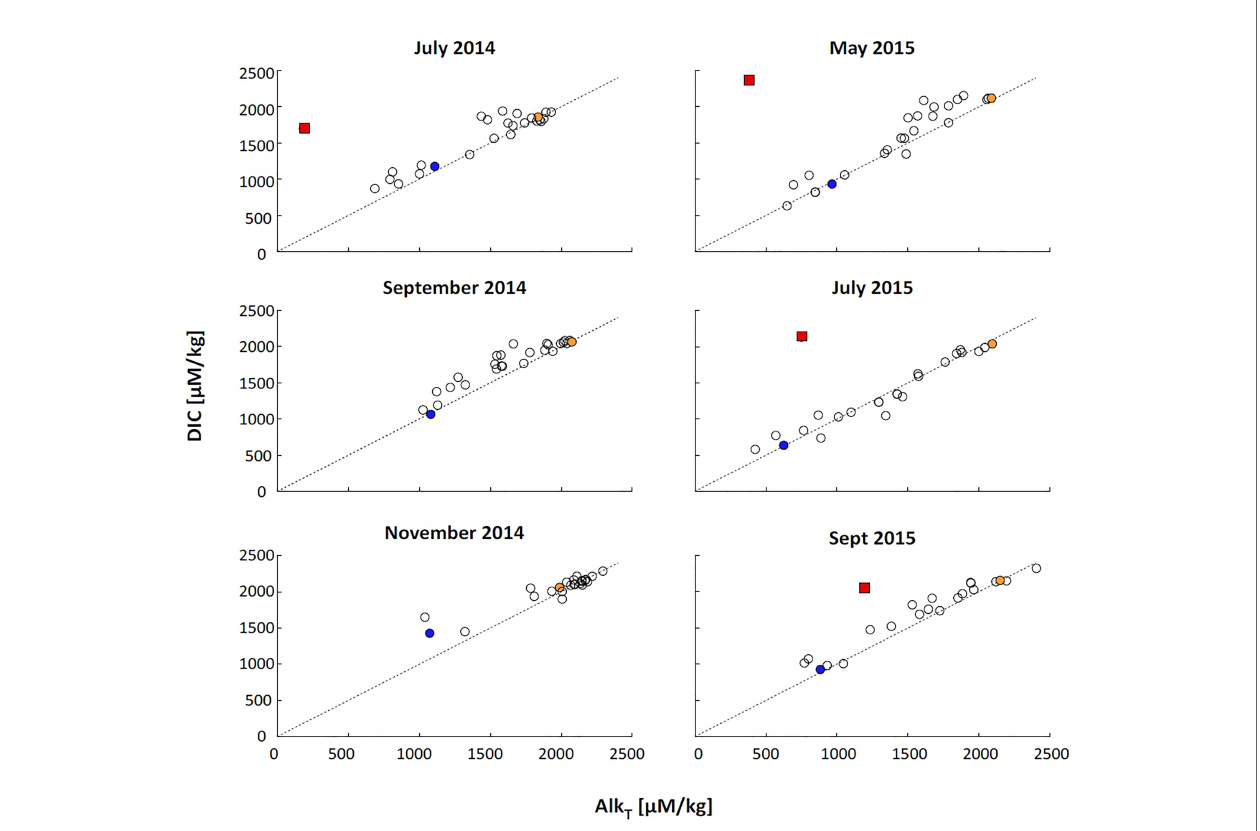
FIGURE 5 | DIC vs. T Alk T . Dotted line shows a 1:1 ratio. Lowest (blue) and highest (orange) salinity sample are indicated. With the exception of the lowest measured salinity in November 2014, salinity end-members fall on the 1:1 line, supporting a DIC: T Alk T ratio of 1 without the in fl uence of reactions. Samples that had high concentrations of sulfate and precipitated HgS due to HgCl 2 fi xation are marked with red